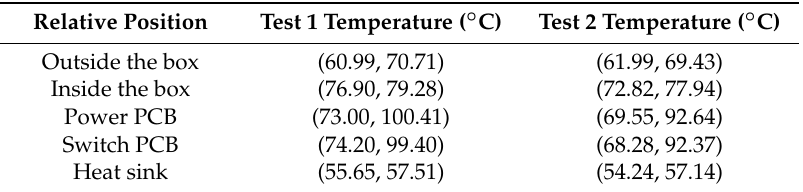
Table 18. Summary of thermal balance test results.